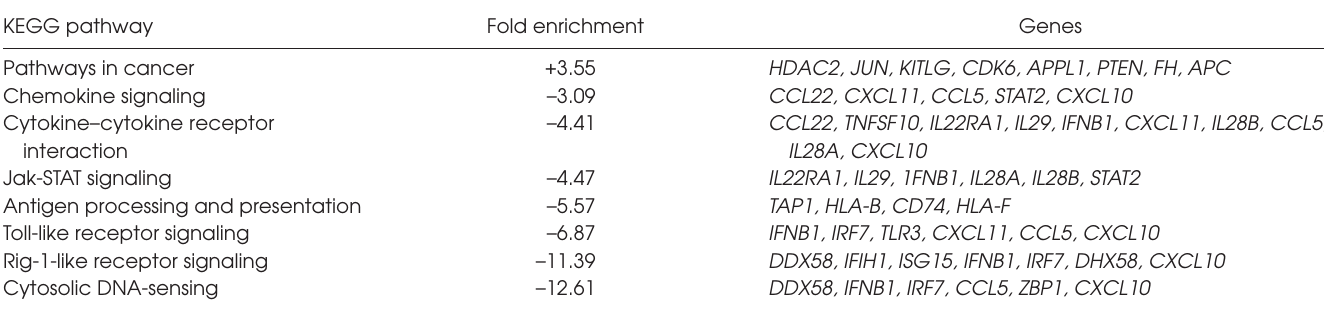
Table 2. KEGG analysis of pathways regulated by miR-187. KEGG pathway Fold enrichment Genes Pathways in cancer